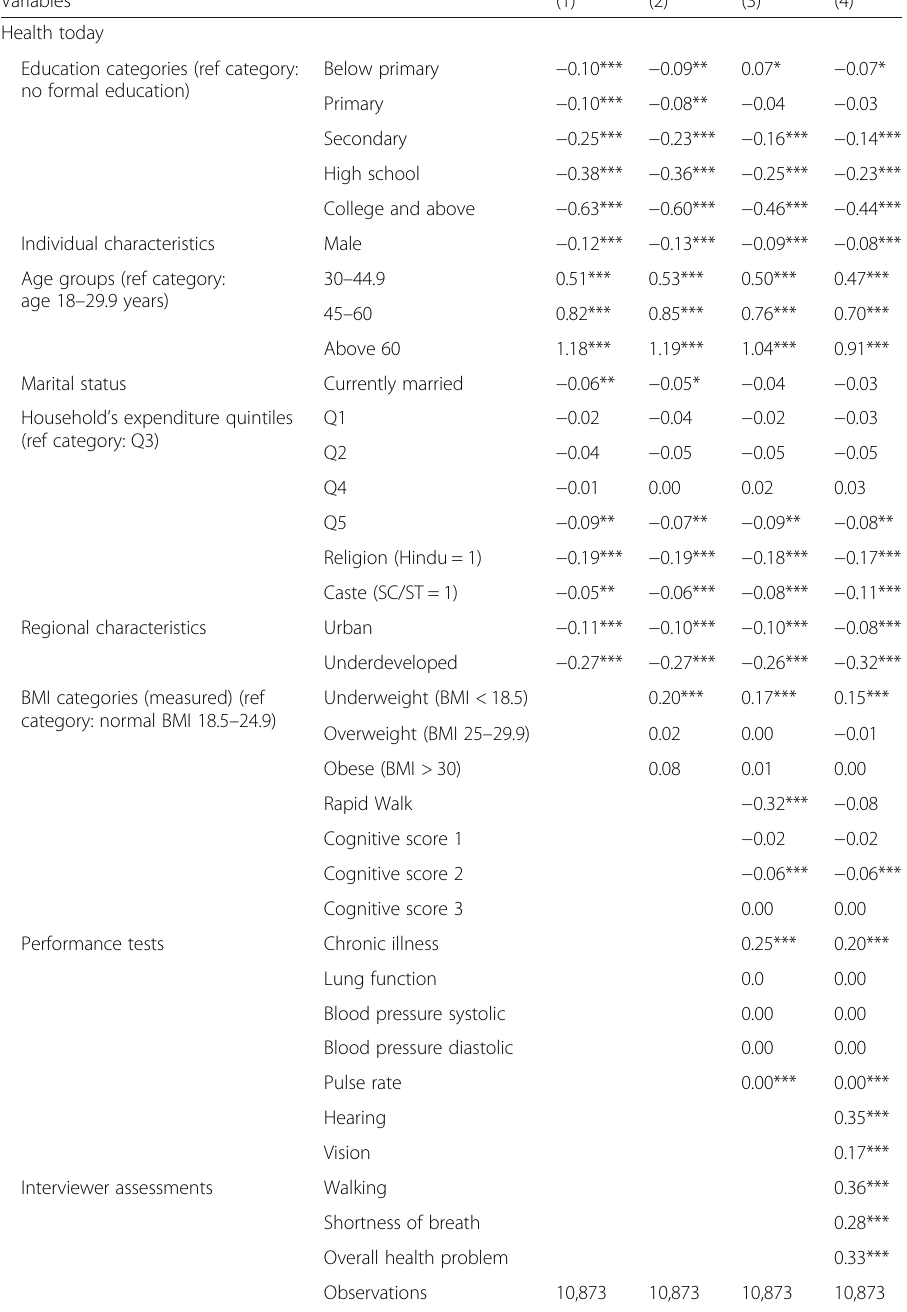
Table 6 Dependent variable: self-reported health Variables Health